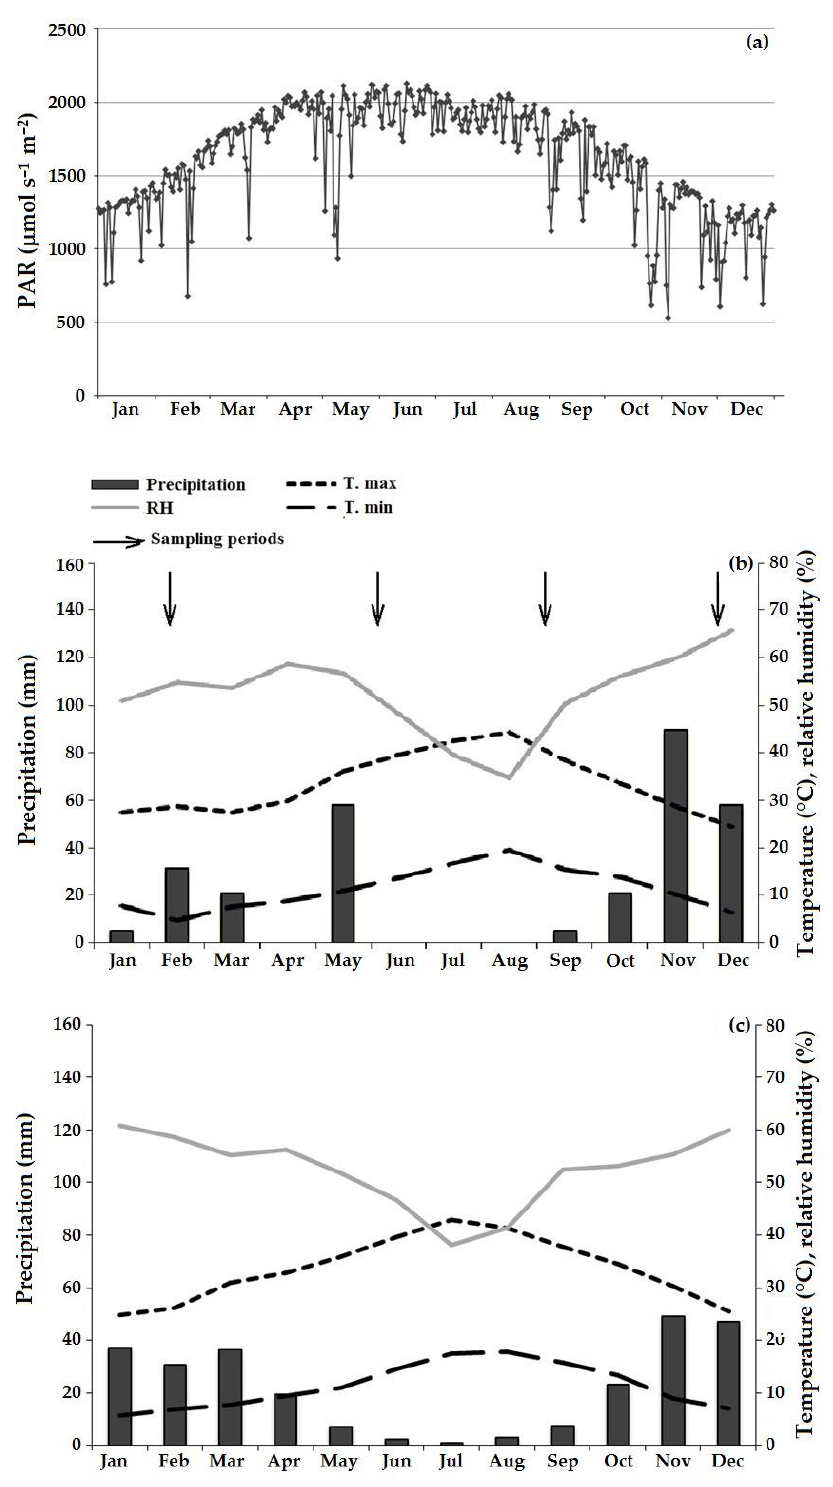
Figure 2. ( a ) Daily maximum photosynthetically active radiation (PAR, µmol s −1 m −2 ), and ( b ) Annual precipitations (mm), monthly relative humidity (RH, %), monthly maximum and minimum temperature (°C) during the study period (from January to December 2016) in the Admine forest.( c ) Average (1996 – 2015) annual precipitations (mm), monthly relative humidity (RH, %), monthly maximum and minimum temperature (°C) in the Admine forest. Net photosynthesis rate (A Net ), stomatal conductance (g s ), and instantaneous water use efficiency (WUE i ) exhibited no significant differences between Arg. and Arg-Eph.